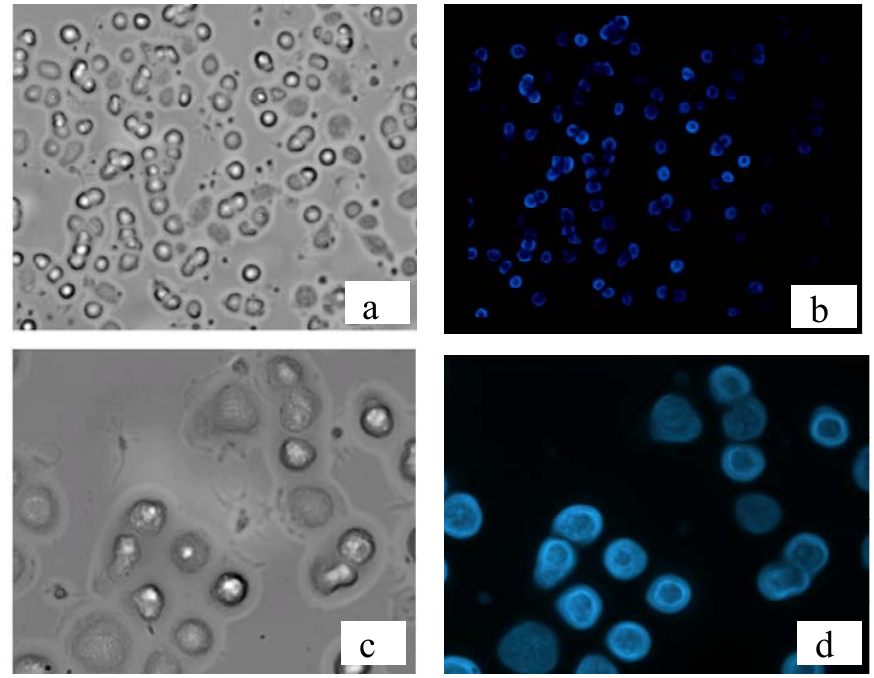
Figure 10. T lymphocytes from a fresh blood sample of a healthy volunteer stained using anti-CD3 mAb labeled with Eterneon TM 350/455 NHS Light transmission ( a , c ) and fluorescence ( b , d ) images. Top: magnification 40×. Bottom: magnification